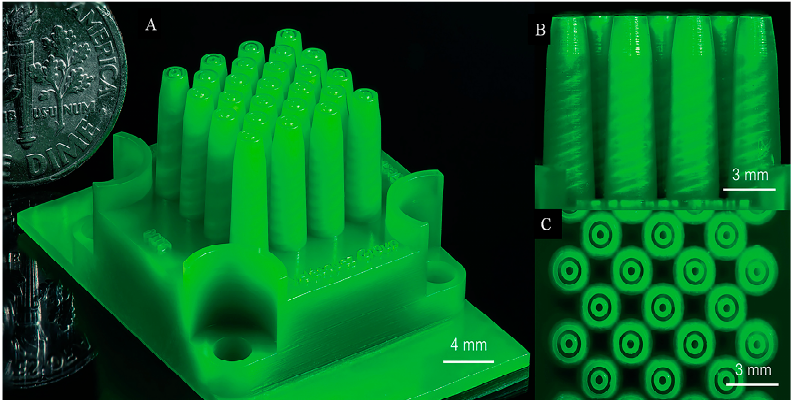
Figure 3. ( A ) Optical image of a 3D-printed planar array of 25 MEMS coaxial electrospray emitters in 1 cm 2 of active area with a US dime coin for comparison. ( B ) Side view of the device, showing the tapered helical channels inside the tapered emitters. ( C Top view of the device, showing the array of coaxial nozzles (Adapted from [36] ) .